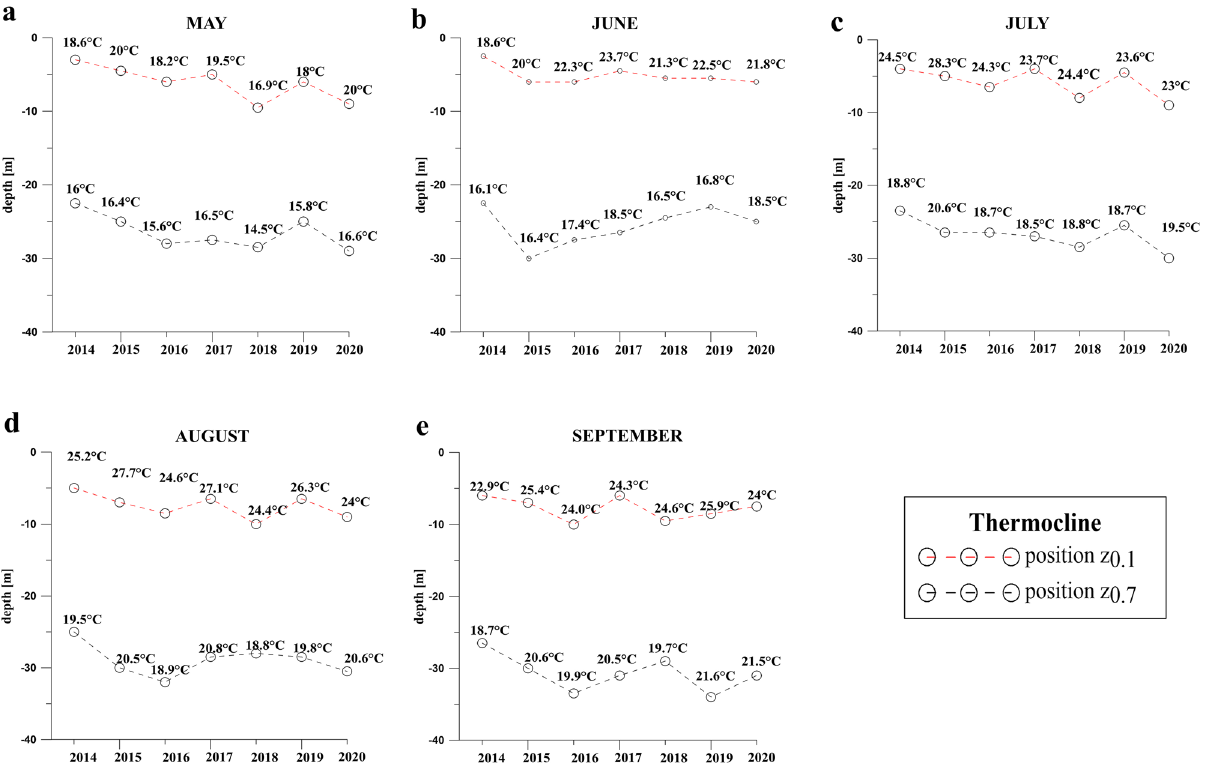
Figure 8. Position of thermocline at Tremiti Islands during late spring and summer, from 2014 to 2020, modelled using MIKE 3 FM HD based on measured data. ( a ) May; ( b ) June; ( c ) July; ( d ) August and ( e )